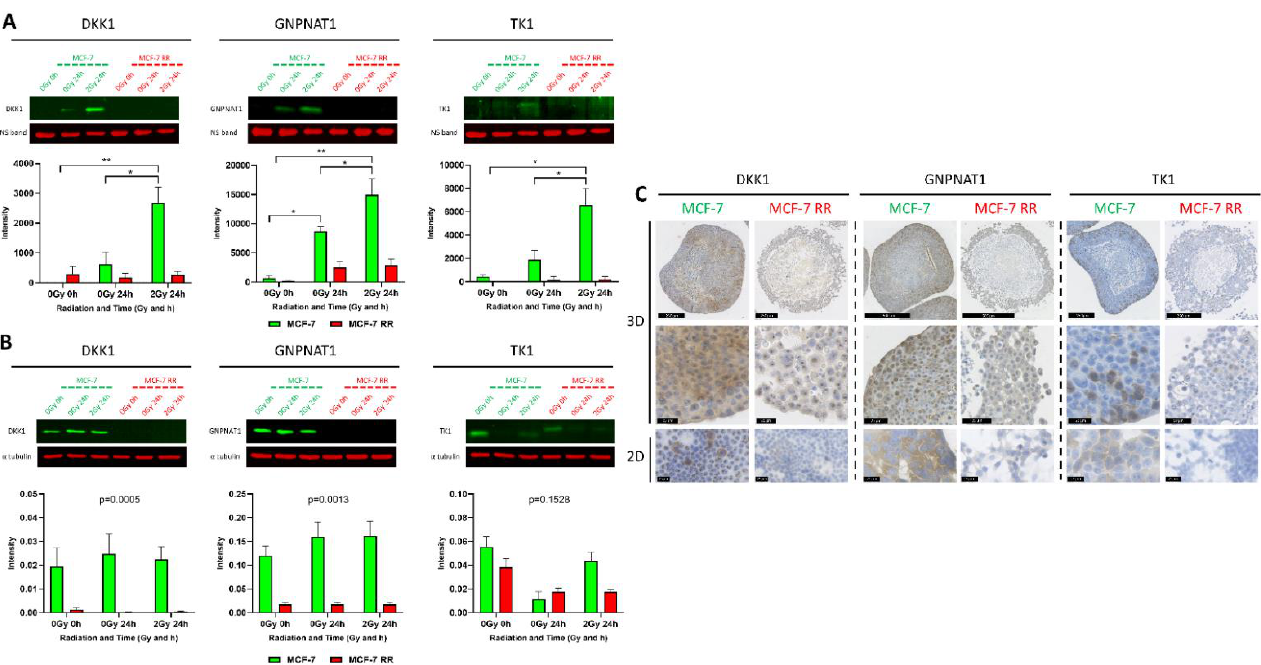
Figure 8. In vitro validation of lead candidate biomarkers. ( A ) WB analysis assessing the secretion levels of lead candidate biomarkers in MCF-7 and MCF-7 RR cell lines using CM samples obtained up to 24 h following 2 Gy of radiation. NS is a non-specific band used to confirm equal loading (One-way ANOVA with Holm –Šíd ák multiple comparisons test; data expressed as mean ± SEM, n = 3, * p ≤ 0.05, ** p ≤ 0.01). ( B ) WB analysis assessing the intracellular levels of lead candidate biomarkers in whole-cell lysates of MCF-7 and MCF-7 RR cell lines obtained up to 24 h following 2 Gy of radiation (Two-way ANOVA; data expressed as mean ± SEM, n = 3). ( C ) IHC assessing the intracellular levels of the lead candidate biomarkers in MCF-7 and MCF-7 RR cells cultured in 2D and 3D environments.